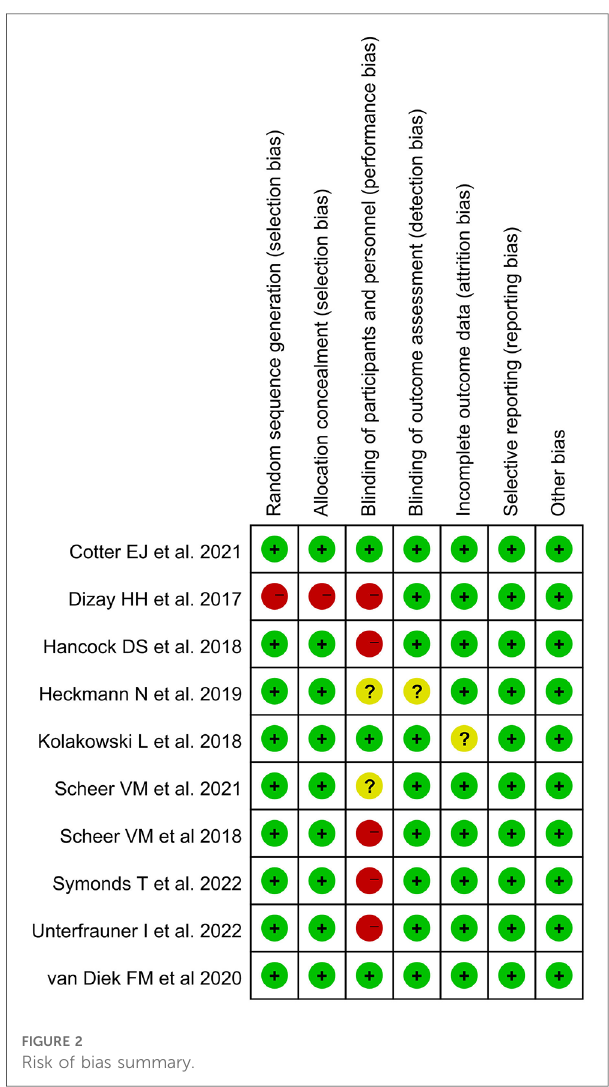
FIGURE 2 Risk of bias summary.